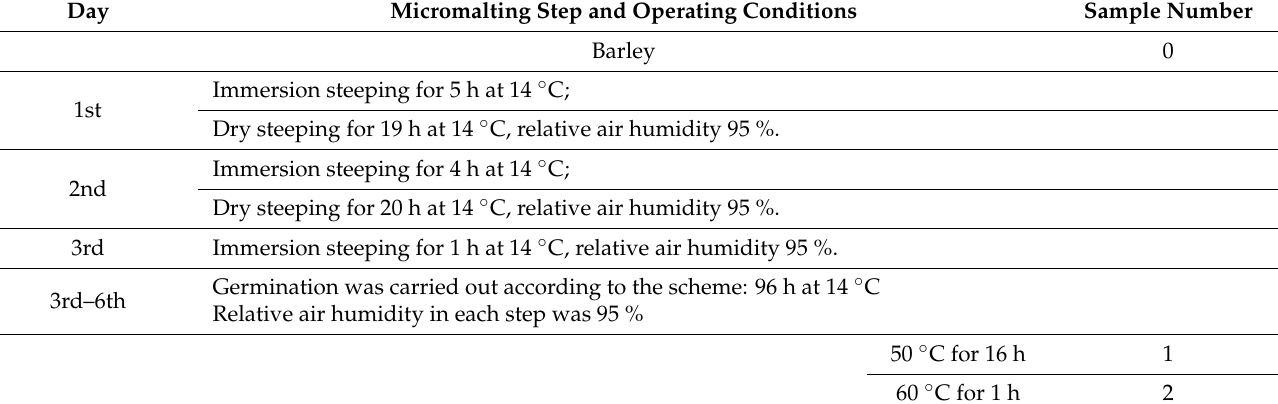
Table 1. General micromalting scheme of barley